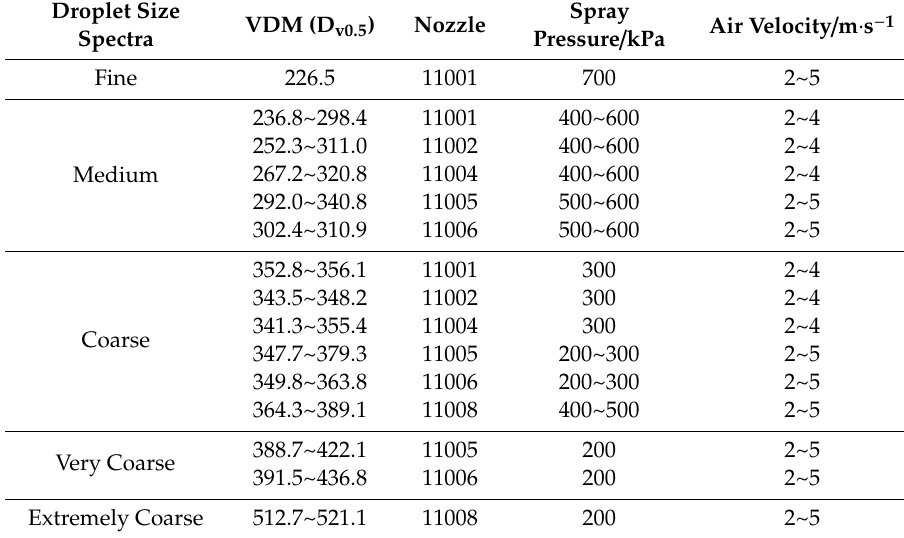
Table 5. Droplet size classification categories for air induction nozzles (AIN) based on the